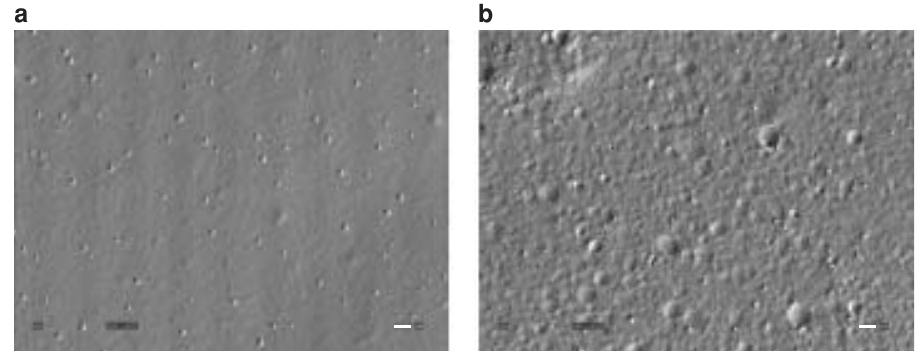
Figure 1 SEM images of conventional and nano-structured PLGA. SEM images confirmed that compared to (a) untreated conventional PLGA, (b) treated nano-structured PLGA had a higher degree surface roughness. Scale bar (lower right) is 10 µ